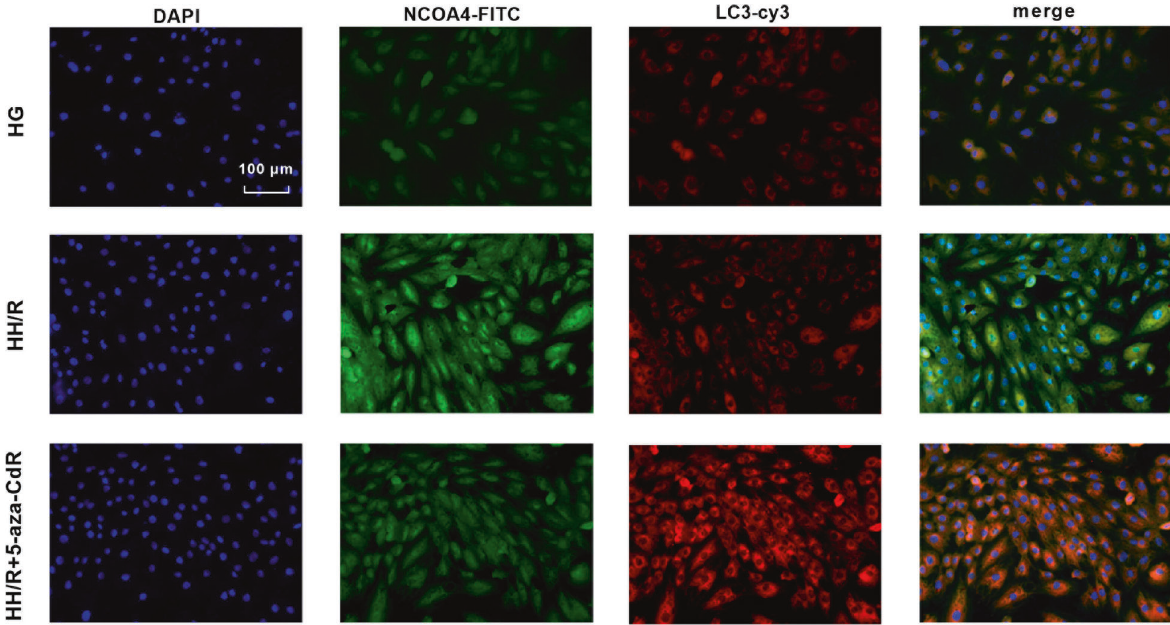
Fig. 6 Ferritinophagy was detected by LC3 and NCOA4 colocation by immuno fl uorescence. Effect of DNMT-1 on ferritinophagy in HH/R H9c2